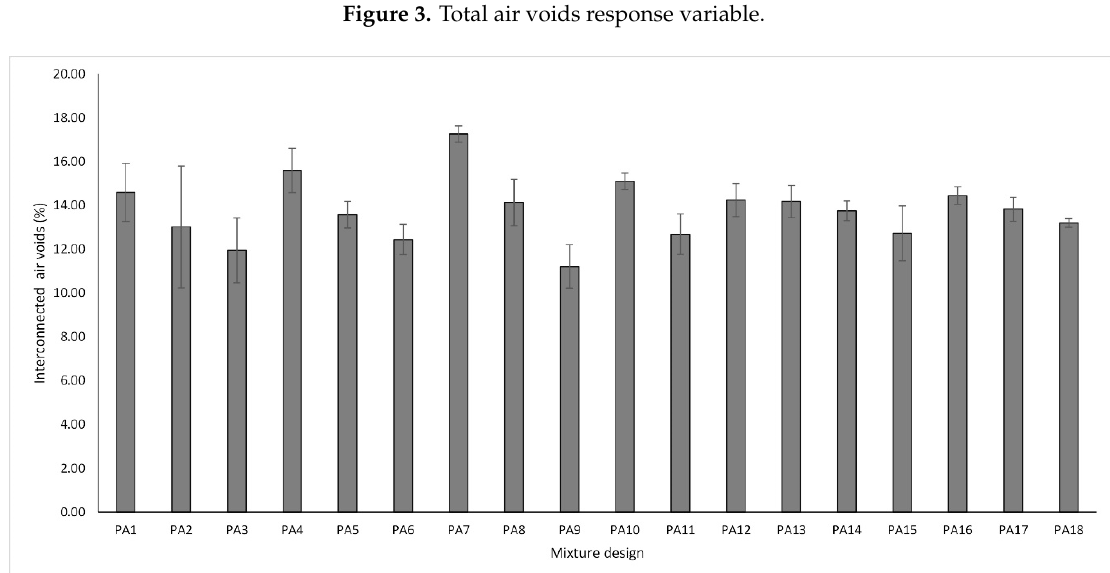
Figure 4. Interconnected air voids response variable.